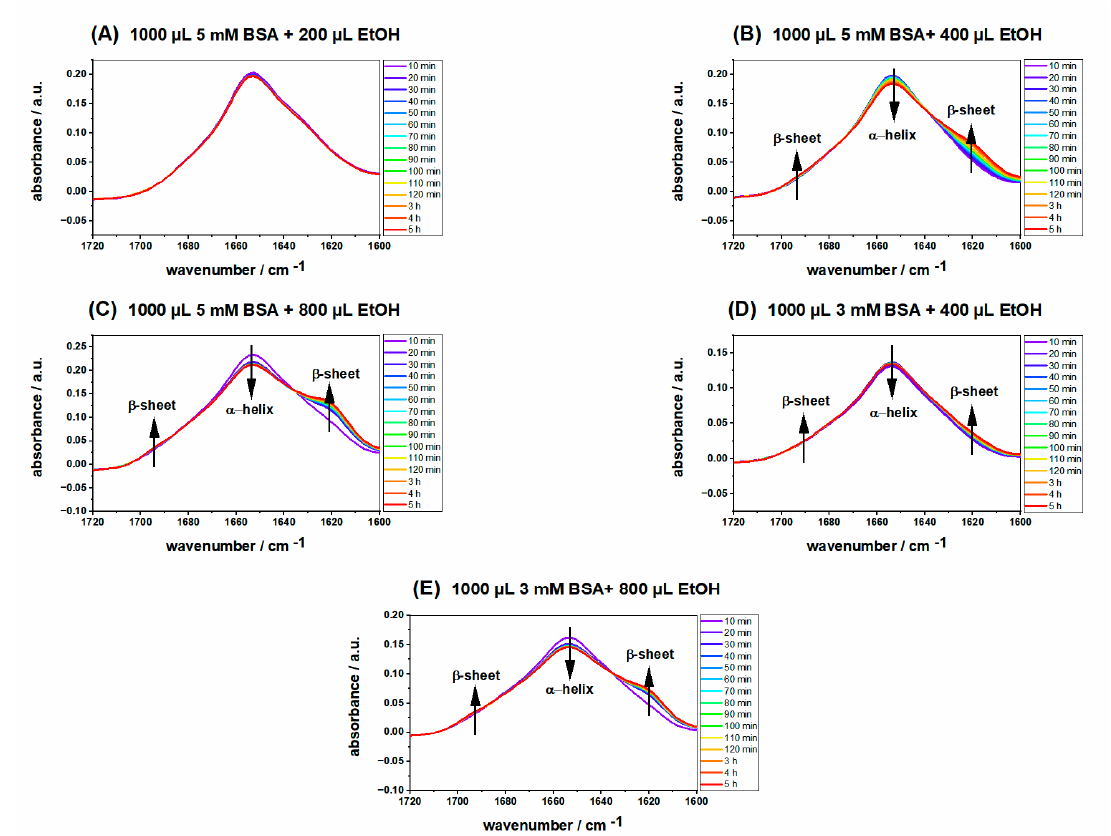
Figure 3. Time dependence of IR absorption spectra of 1000 µL ( A ) 5 mM BSA precursor solution with 200 µL ethanol, ( B ) 5 mM BSA precursor solution with 400 µL ethanol, ( C ) 5 mM BSA precursor solution with 800 µL ethanol, ( D ) 3 mM BSA precursor solution with 400 µL ethanol, and ( E ) 3 mM BSA precursor solution with 800 µL ethanol. All of the samples were measured at 37 °C on ATR IR crystal.